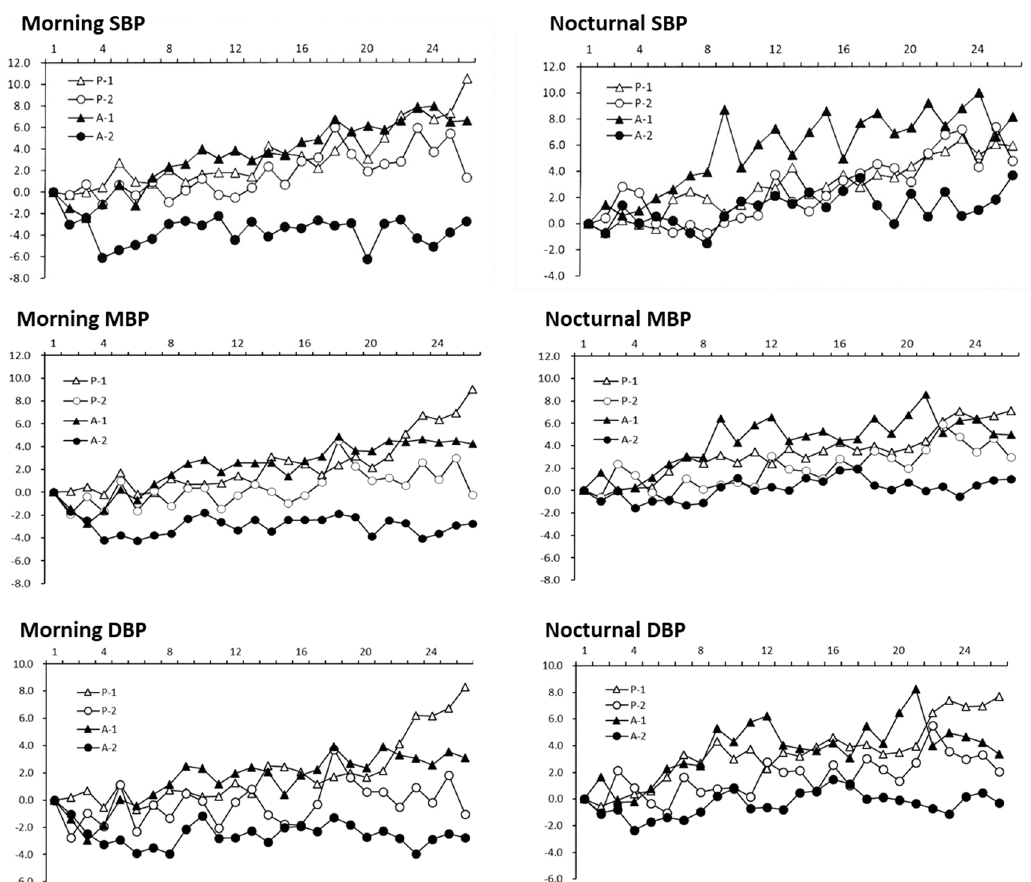
Figure 1. Effects of Perilla frutescens leaf powder (PLP) intake on mean changes in home systolic, mean, and diastolic blood pressure. Self-measurement of blood pressure at home was performed daily with an automatic upper-arm device, after waking up (morning systolic blood pressure [SBP], morning mean blood pressure [MBP], and morning diastolic blood pressure [DBP]) and before going to bed (nocturnal SBP, nocturnal MBP, and nocturnal DBP). P-1 ( ∆ ), placebo-treated subjects who ingested pectin fiber with SBP < 120 mmHg ( n = 7); P-2 ( ○ ), placebo ‐ treated subjects who ingested pectin fiber with SBP ≥ 120 mmHg ( n = 5); A-1 ( ▲ ), subjects who ingested PLP and had SBP < 120 mmHg ( n = 10); A-2 ( • ), subjects who ingested PLP and had SBP ≥ 120 mmHg ( n = 8). Each symbol represents the values averaged for 1 week. Data are shown as the mean changes in BP levels (mmHg) from baseline to the estimated week.